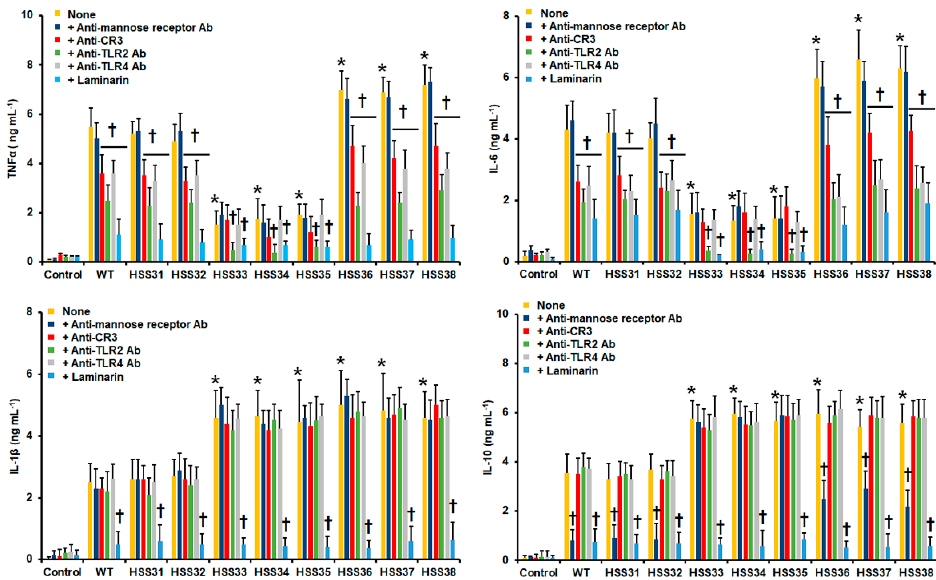
Figure 5. Cytokine stimulation by human peripheral blood mononuclear cells stimulated with Sporothrix schenckii wild-type, control, and ROT2 -silenced strains. Human peripheral blood mononu- clear cells were preincubated for 60 min with 200 μ g mL − 1 laminarin or 10 μ g mL − 1 of any of the following antibodies: anti-mannose receptor, anti-CR3 receptor, anti-TLR2, or anti-TLR4; then, they were coincubated with yeast-like cells for 24 h. In all cases, the interactions were centrifuged, super- natants collected, and cytokines quantified by ELISA. None refers to the system where human cells were preincubated with PBS and then challenged with the fungal cells. Ab, antibody. Control refers to wells where the human cells were preincubated only with PBS. Results are the media ± standard deviation from data generated with samples from eight donors, analyzed by duplicate. * p < 0.05, when compared with the cytokine level stimulated by WT strain. † p < 0.05, when compared with the same strain with no preincubation step.